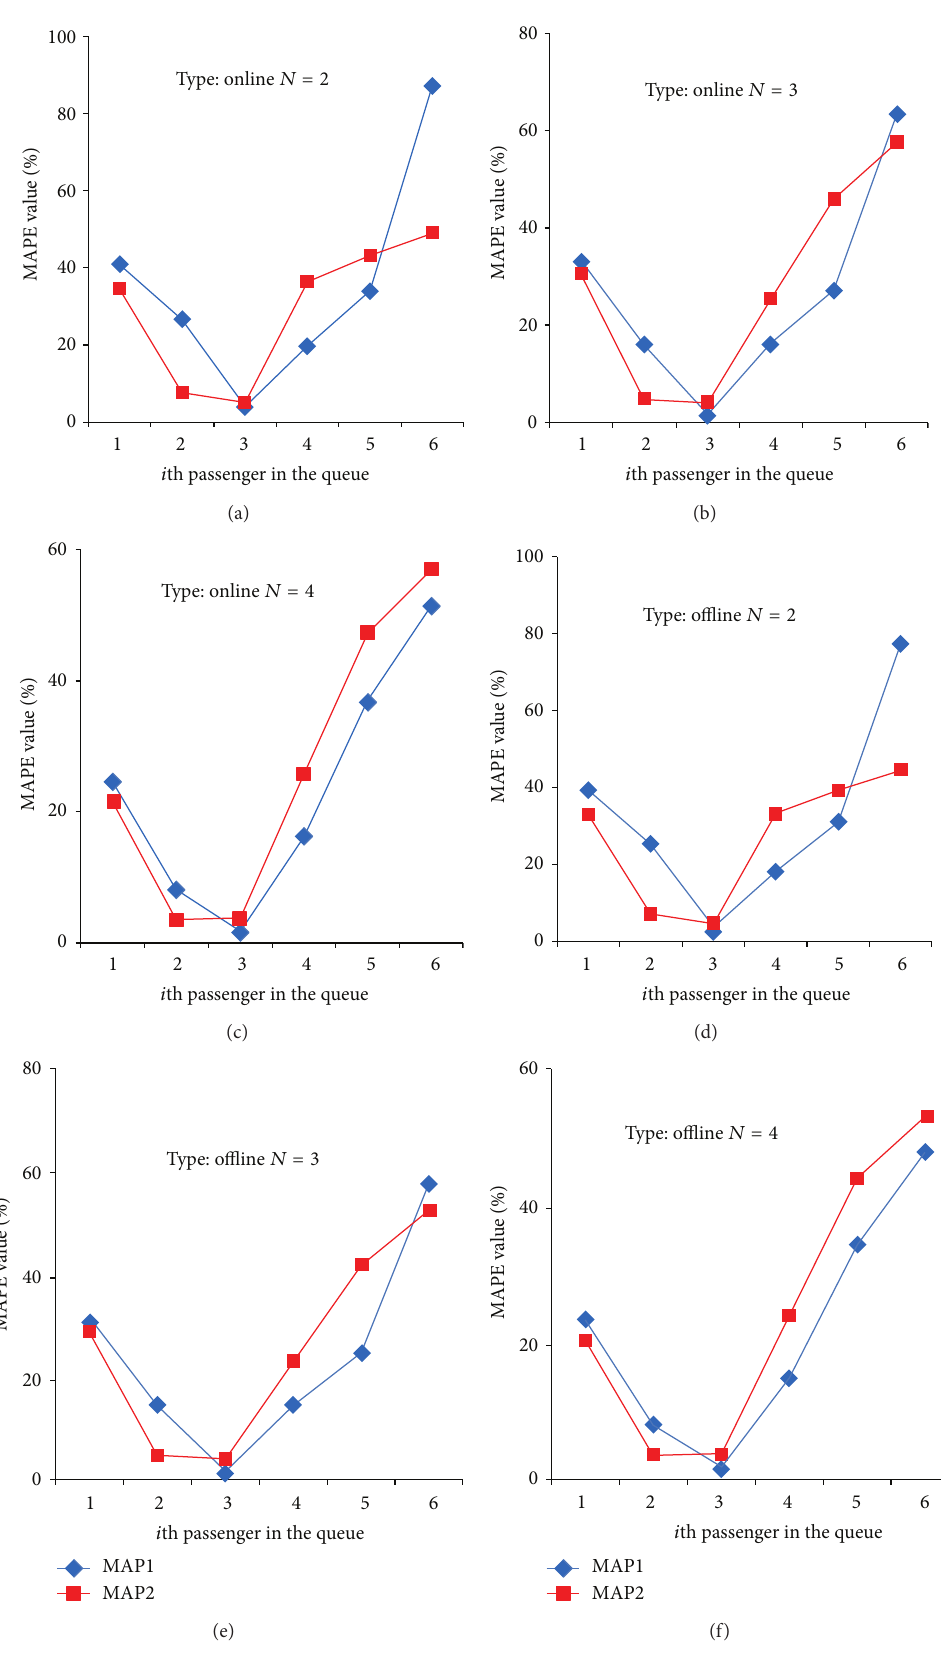
Figure 2: The MAPE value between the estimated and field-measured or simulated average travel time of 𝑖 th passenger in the